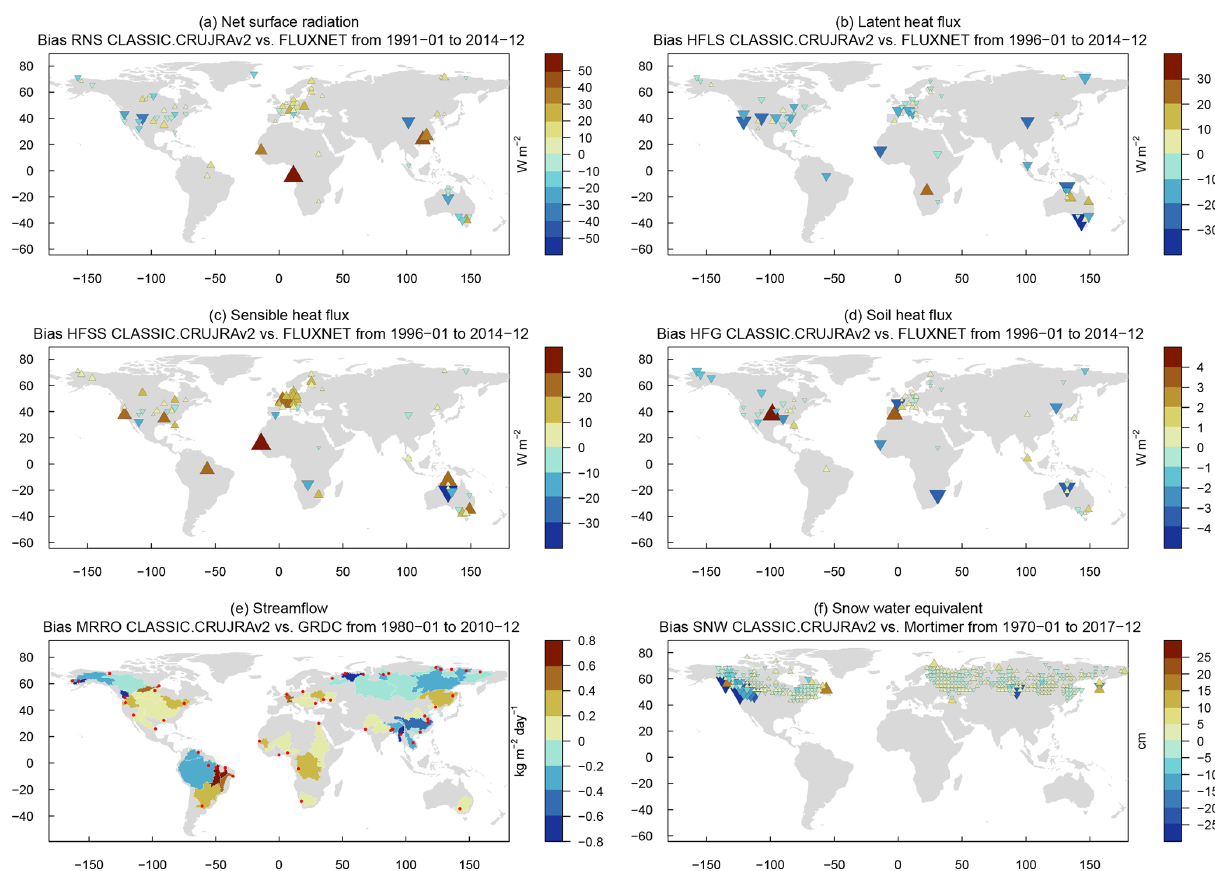
Figure 1. Biases when comparing CLASSIC forced with CRUJRAv2 against in situ measurements of (a) net surface radiation, (b) latent heat flux, (c) sensible heat flux, (d) soil heat flux, (e) streamflow, and (f) snow water equivalent. Measurements located in the same model grid cell were merged. Upward- and downward-pointing triangles indicate positive and negative biases,